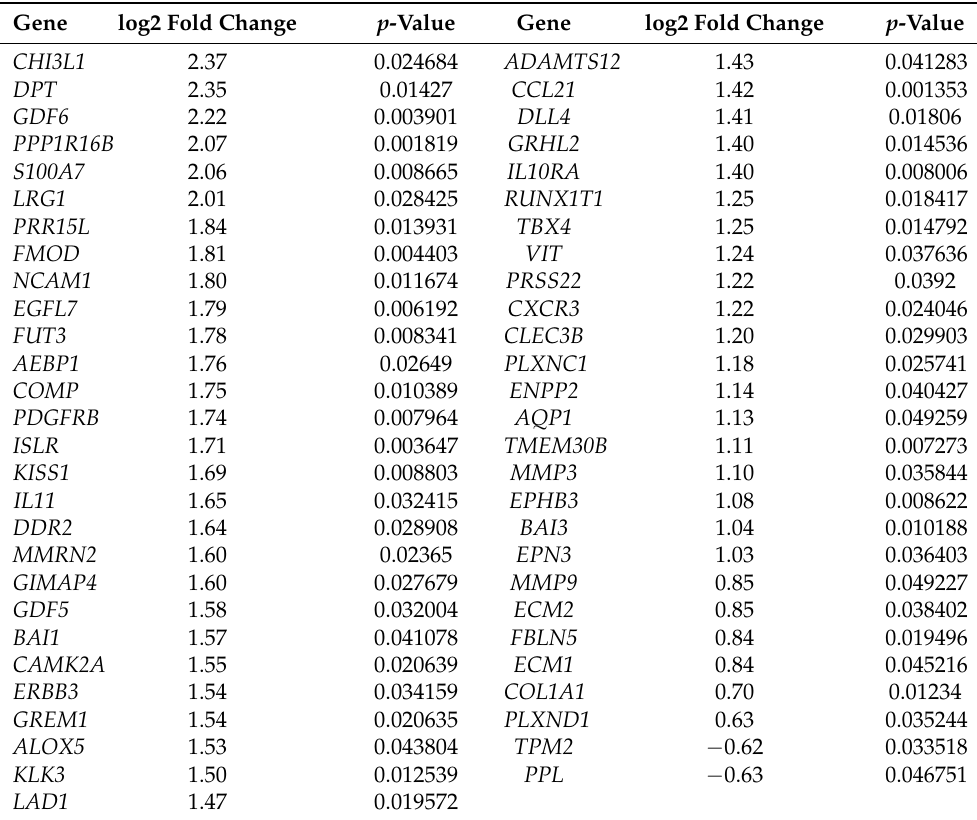
Table 4. Genes deregulated in EV PIC- versus EV C-treated